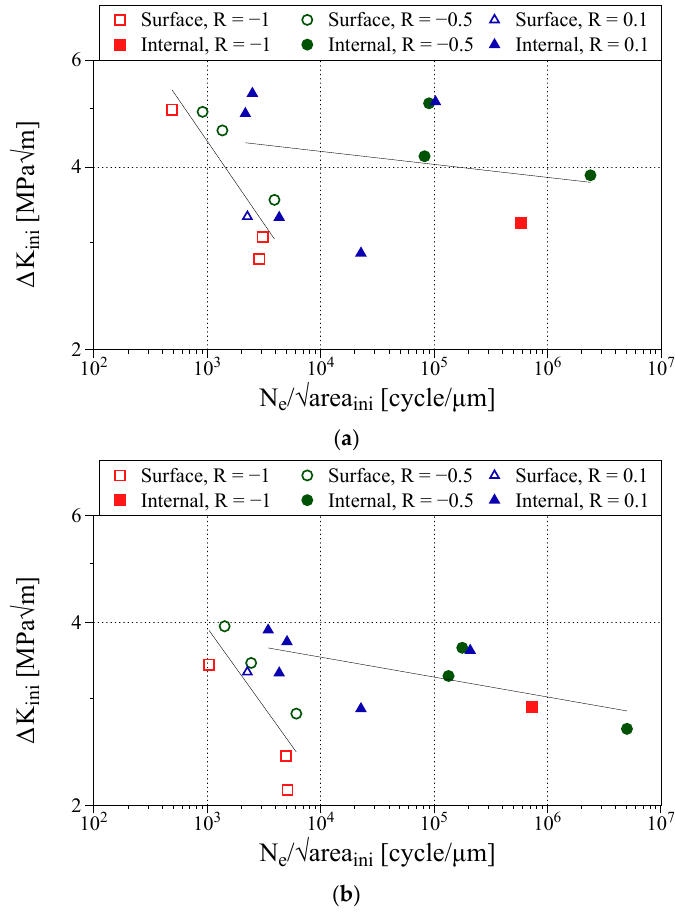
√ area ini diagrams. ( a ) Total facets area (surface: C = 5.04 × 10 − 9 , m = 3.68; Figure 12. ∆(cid:1837) (cid:3036)(cid:3041)(cid:3036) − (cid:1840) (cid:3032) /(cid:3493)(cid:1853)(cid:1870)(cid:1857)(cid:1853) (cid:3036)(cid:3041)(cid:3036) diagrams. ( a× ) Total facets area (surface: (cid:1829) = 5.04 × 10 (cid:2879)(cid:2877) , (cid:1865) = Figure 12. ∆ K ini − N e / 3.68 ; internal: (cid:1829) = 2.1 × 10 (cid:2879)(cid:2871)(cid:2876) , (cid:1865) = 46.7 ); ( b ) Major facet(s) area (surface: (cid:1829) = 5.76 × 10 (cid:2879)(cid:2877) , internal: C = 2.1 × 10 − 38 , m = 46.7); ( b ) Major facet(s) area (surface: C = 5.76 × 10 − 9 , m = 3.84; (cid:1865) = 3.84 ; internal: (cid:1829) = 1.72 × 10 (cid:2879)(cid:2870)(cid:2873) , (cid:1865) = 30.5 ). internal: C = 1.72 × 10 − 25 , m = 30.5